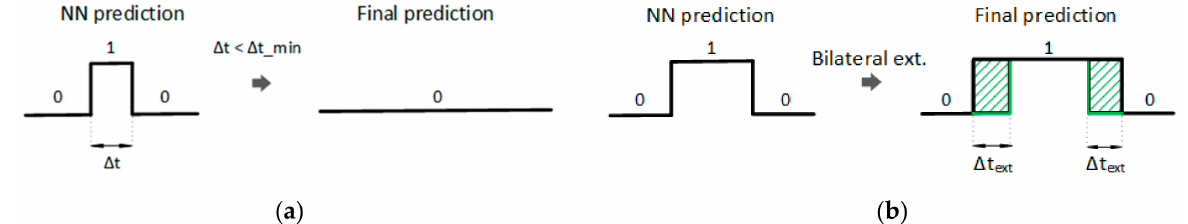
Figure 3. ( a ) Minimum duration filtering; if a resulting utterance has a shorter duration than a reference value, ∆ t min , it is discarded; ( b ) Bilateral extension; the utterance start time is lowered by a